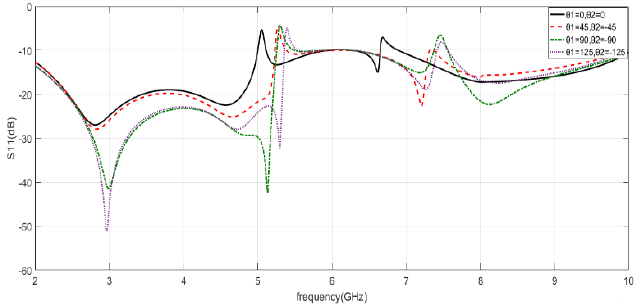
Figure 8: Simulated S characteristics of proposed antenna 11 loaded with ESRR2 and ESRR4 for various rotation angles.